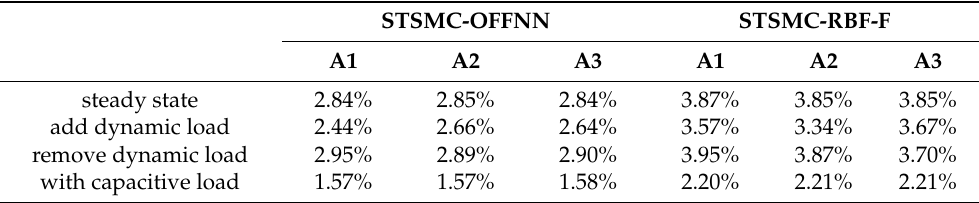
Table 3. Performance comparisons of STSMC-OFFNN and STSMC-RBF-F.